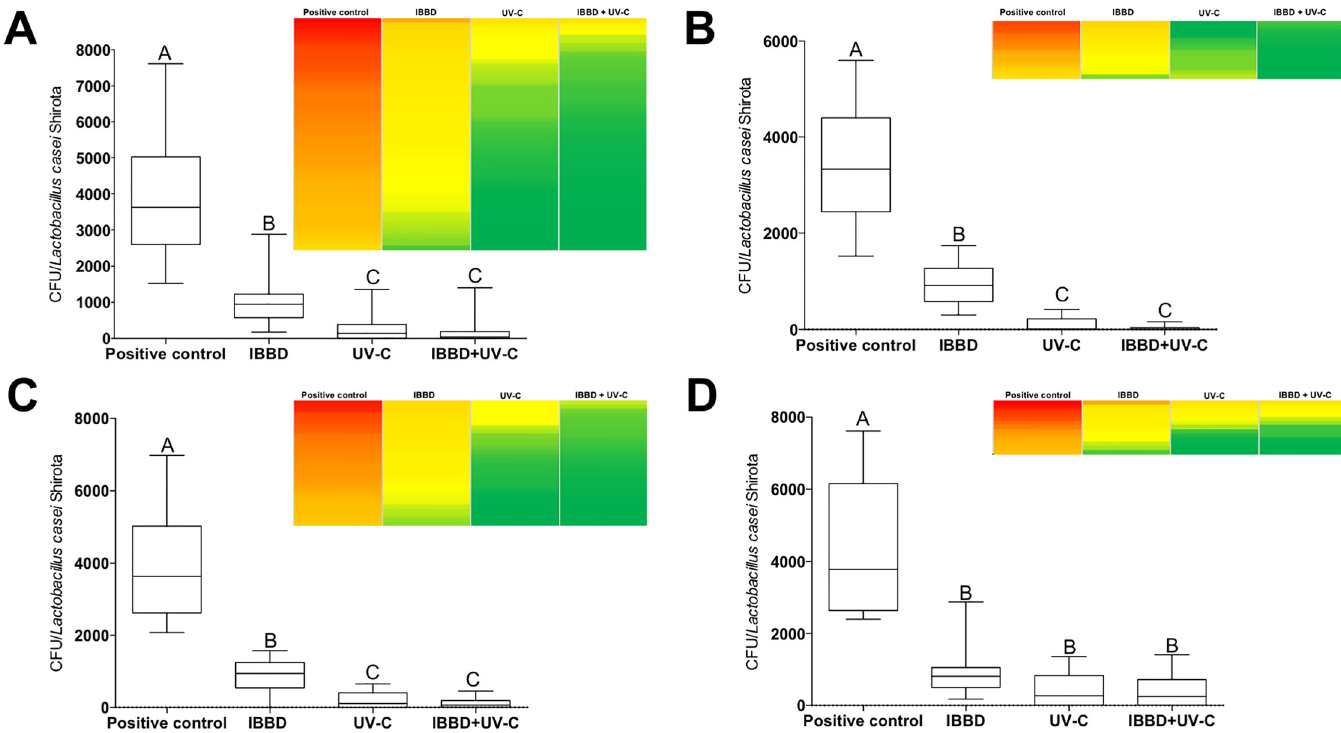
Fig 1. Box plot of the data of the CFU counts and a heat map of the dispersion of the counts of the plates on the different surfaces analyzed. Data of all surfaces analyzed in a grouped manner (A); fluorescent lamp fixtures (B); in the stands (C) and on the floor (D). Different letters indicate statistical significance (p < 0.0001). One-way ANOVA and post hoc analysis using Tukey’s multiple